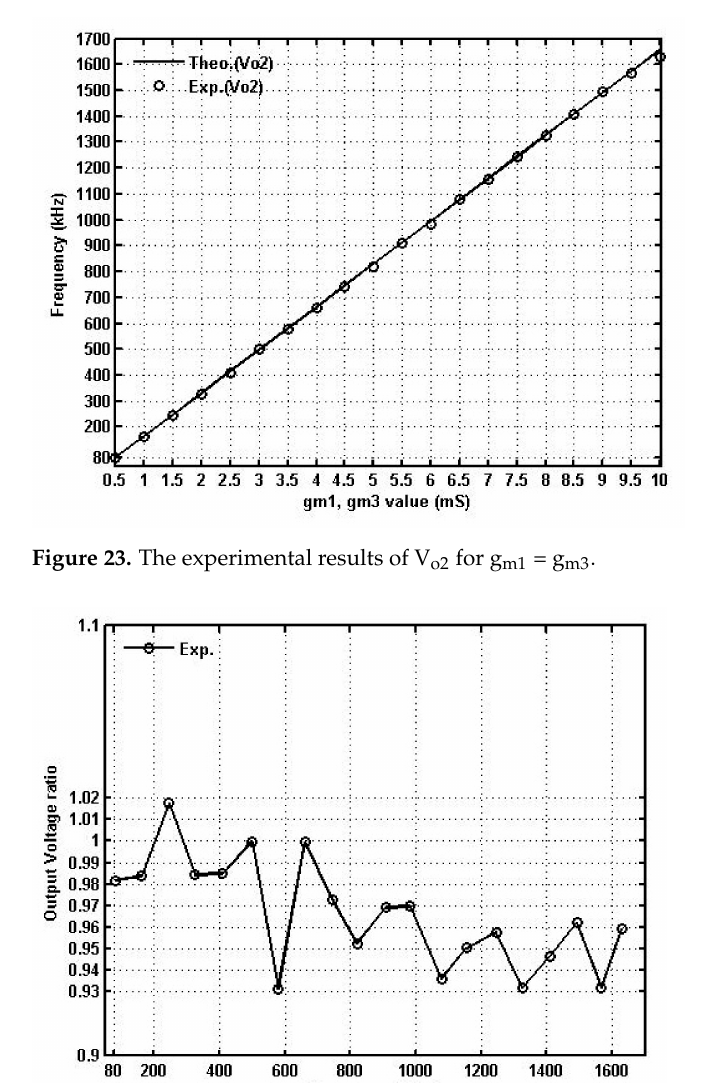
Figure 22. The measured phase noise performance of the VM QSO at the V o2 output terminal.